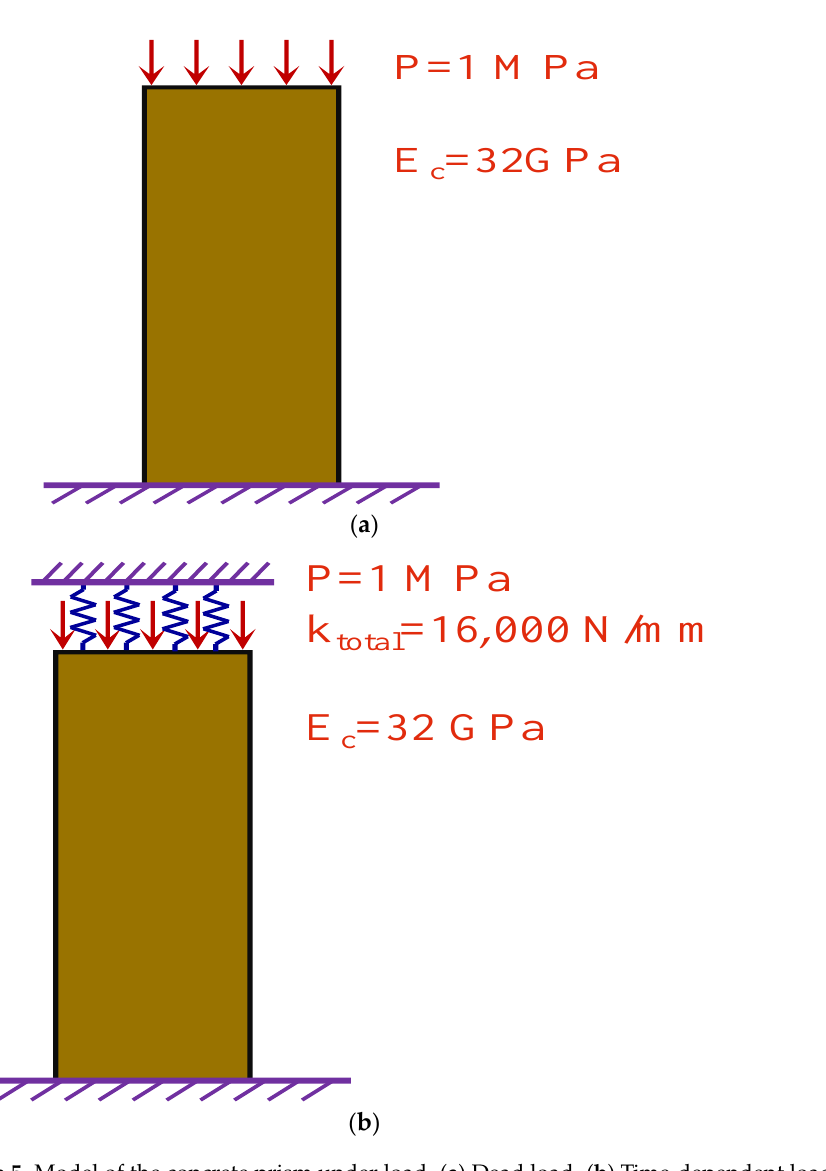
Figure 5. Model of the concrete prism under load. ( a ) Dead load. ( b ) Time-dependent loading. In Figure 5, the bottom surface of the model is fixed, and the spring is set on the top surface. In addition, the spring stiffness was changed to simulate different load